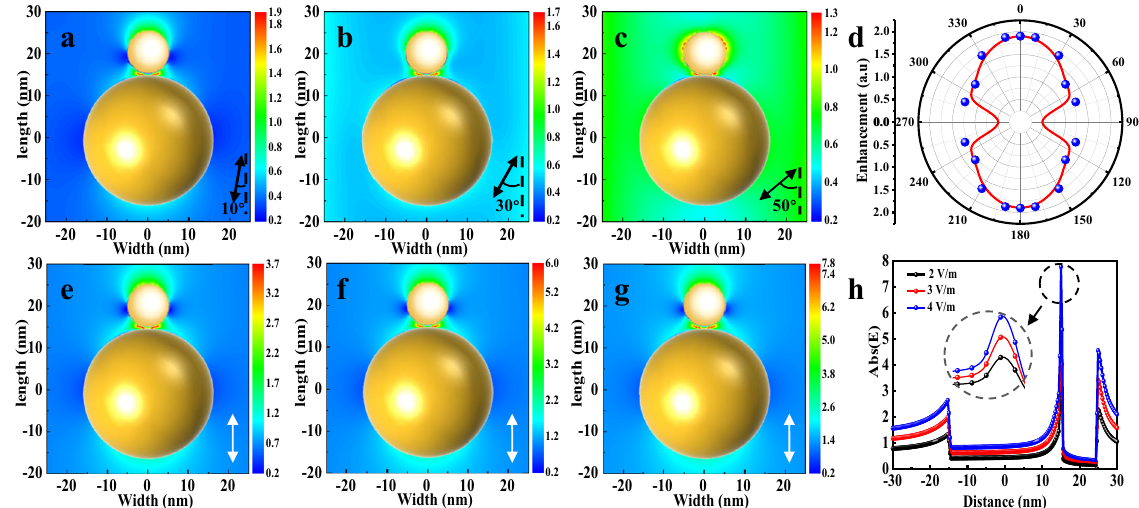
Fig. 5 Calculated electric fi eld distribution of Pt/CeO 2 irradiated with 800-nm laser pulse. Polarization angles of ( a ) 10°, b 30°, and ( c ) 50°. d Simulated dependence of the enhanced electric fi eld at the interface between Pt and CeO 2 on the polarization angles. Calculated electric fi eld distribution of Pt/CeO 2 irradiated with laser intensities of ( e ) 2 V m − 1 , f 3 V m − 1 , g 4 V m − 1 . h The electric fi eld along the longitudinal axis of the Pt/CeO 2 excited at 800-nm wavelength. Inset is the enlarged image of the electric fi eld at the interface between Pt and CeO 2